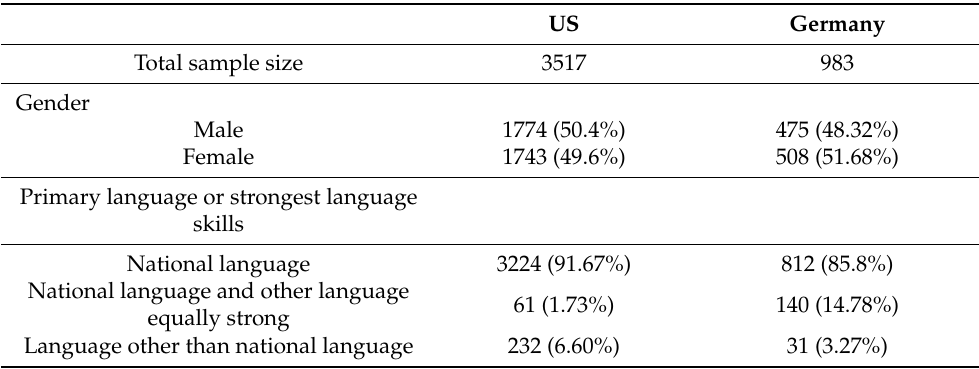
Table 2. Overview of the Samples from the Two